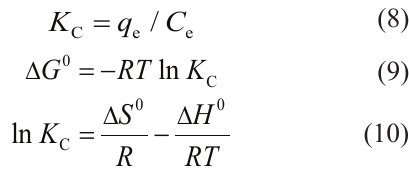
Table 2 – Temkin, Langmuir and Freundlich constants for sorption of chromate on IL-rGO sorbent Langmuir Freundlich Temkin Sorbent